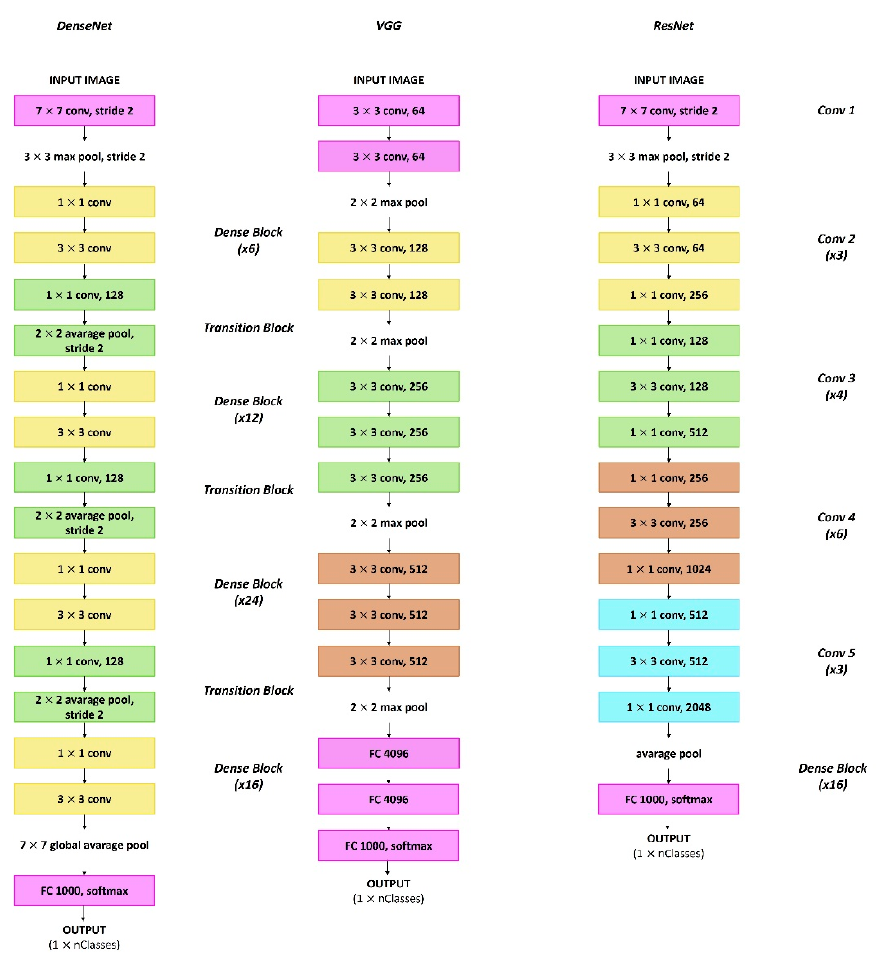
Figure 4. The three CNN architectures used.